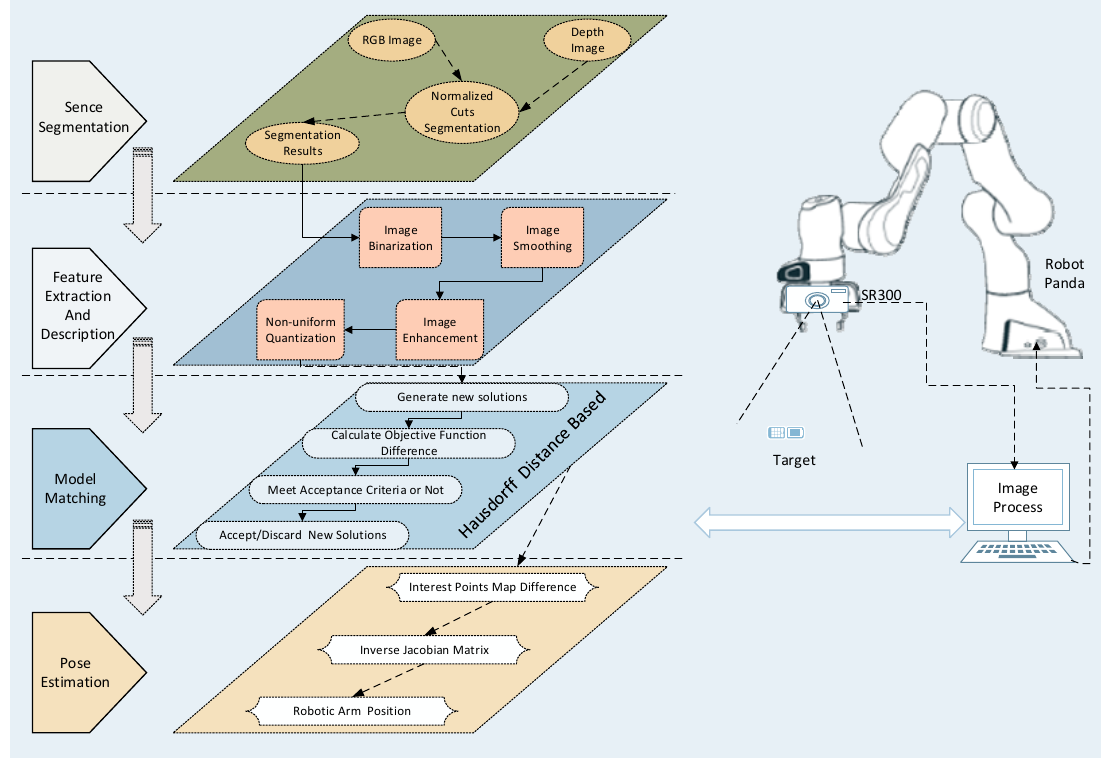
Figure 1. Visual servo control structure and image processing composition.